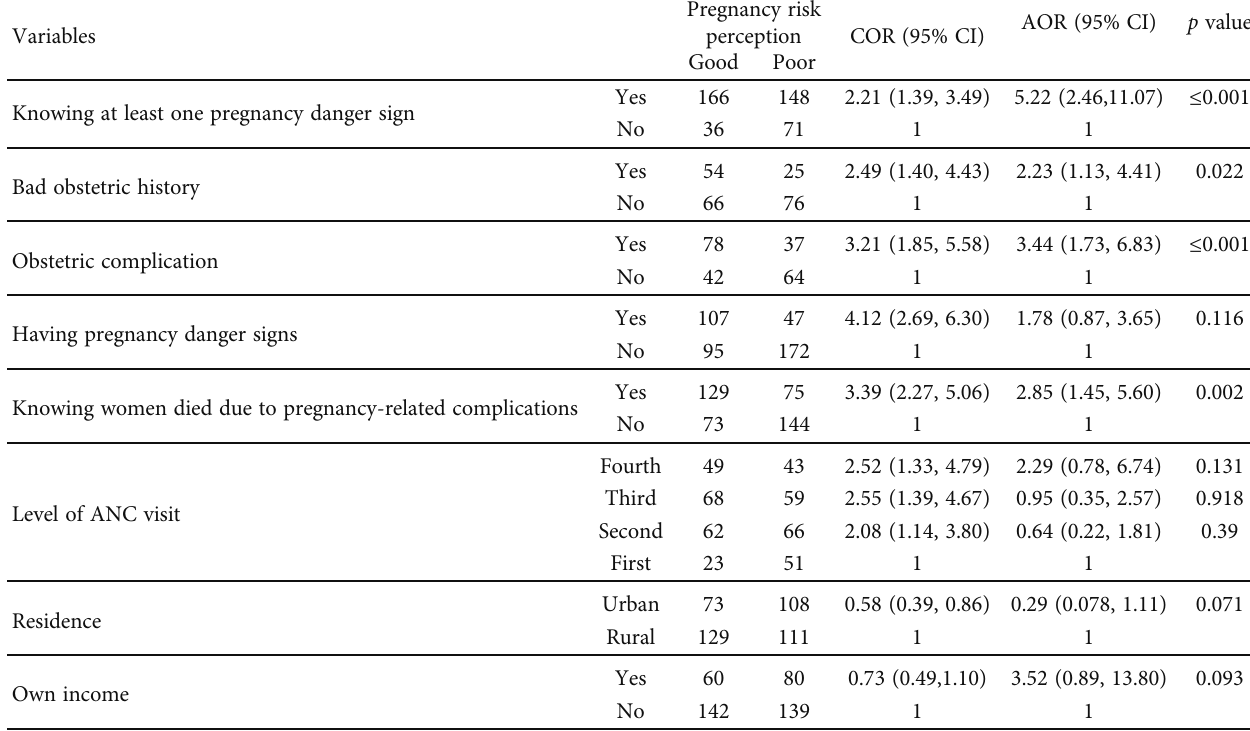
Table 5: Factors a ff ecting pregnancy risk perception of pregnant women attending antenatal care at Jabi Tenhan District health centers in April 2021 ( n = 421